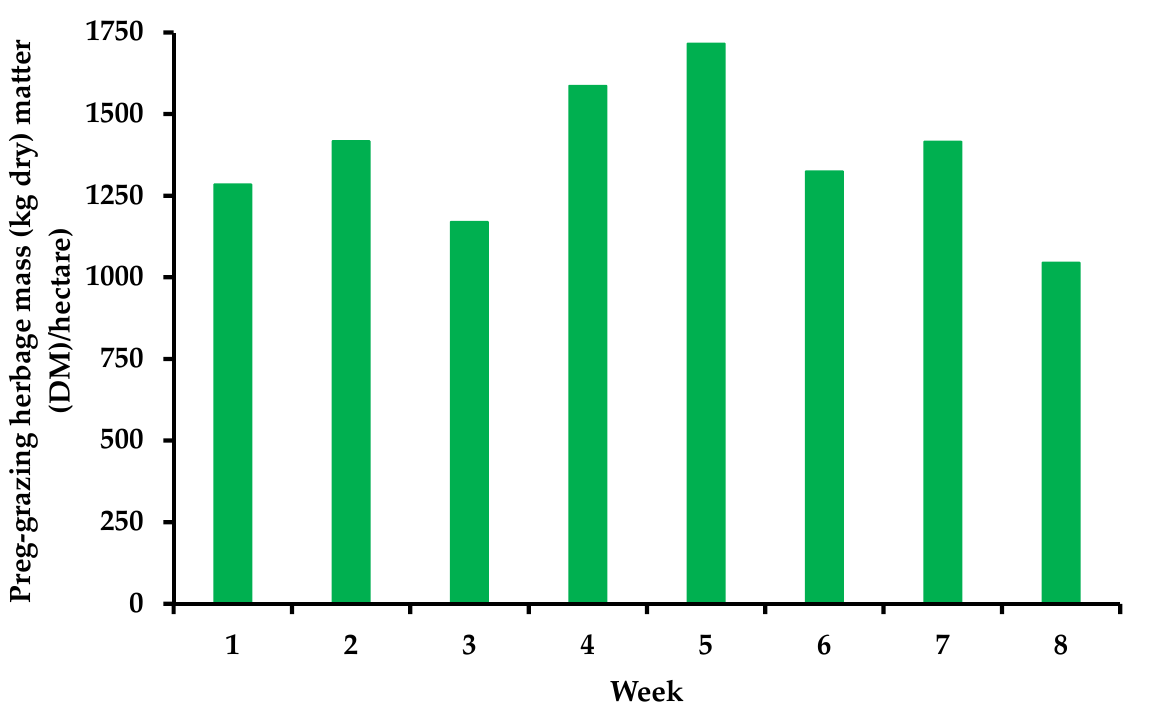
Figure 1. Changes in pre-grazing herbage mass on a weekly basis.